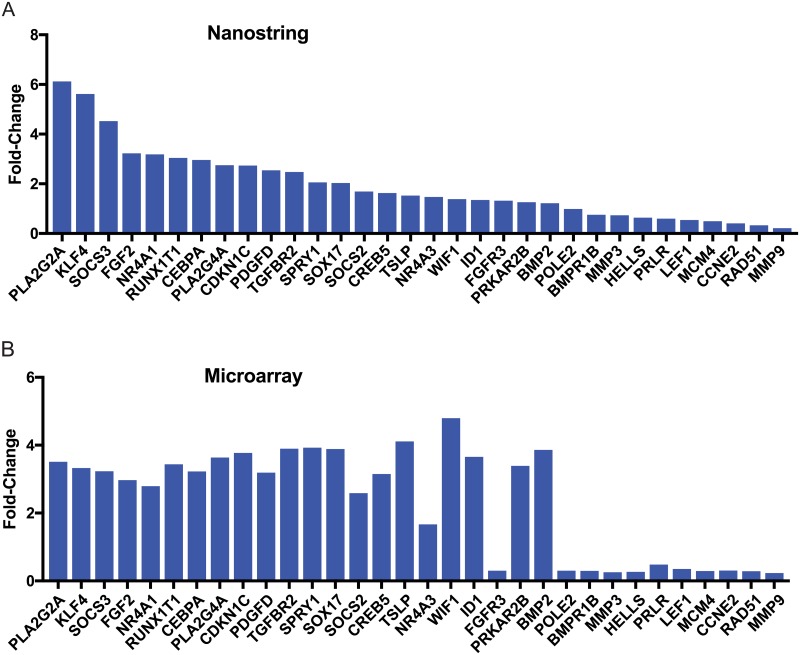
Nanostring validation of gene expression array data.(A) Thirty-two genes were selected from the gene expression profile of the 20 mm region that were in common between gene expression arrays and present on the Nanostring pan-cancer pathway gene set. Three patients were analyzed between paired tumor and stromal samples and quantified using NSolver software. (B) Quantified mRNA expression levels obtained from microarray data shown in Fig 3 for the 32 genes selected for Nanostring analysis.